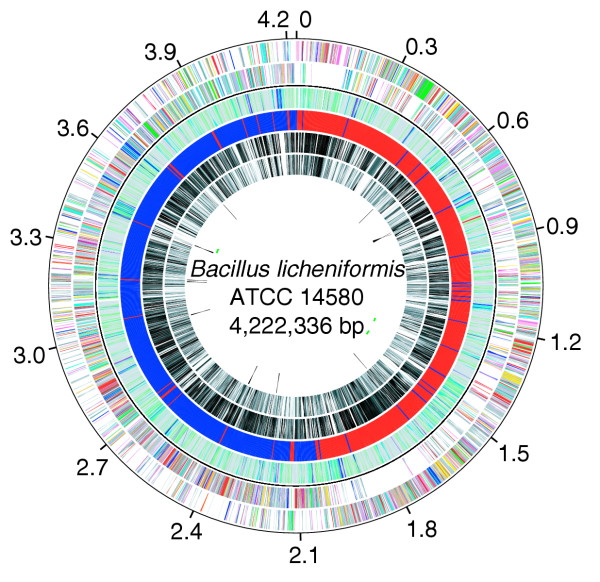
Circular representation of the B. licheniformis ATCC 14580 chromosome. Circles are numbered from 1 (outermost) to 7 (innermost). Circles 1 and 2 show the locations of predicted CDSs on the + and - strands, respectively; circle 3, %G+C; circle 4, GC skew ((G-C/G+C)); circle 5, homology with B. subtilis 168; circle 6, homology with B. halodurans; circle 7 shows positions of nine copies of insertion sequence element IS3Bli1 and a putative transposase gene; small green bars inside circle 7 denote the positions of possible prophage elements.